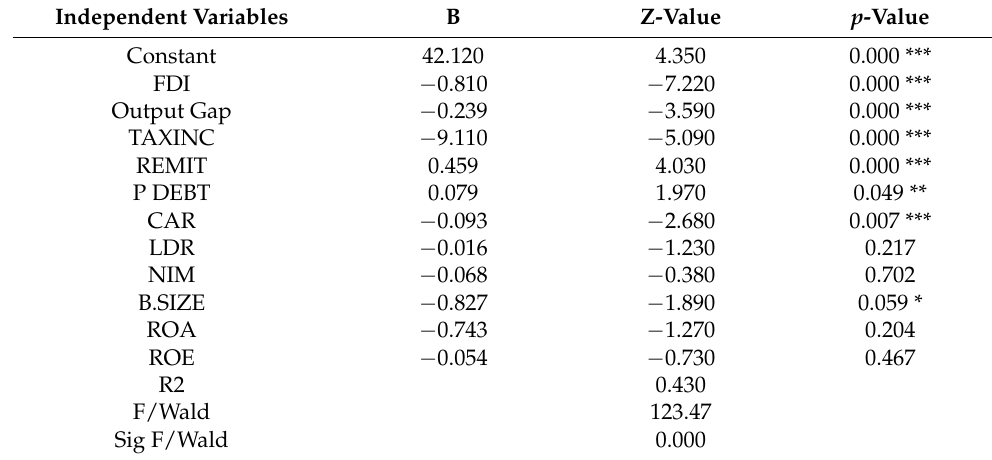
Table 8. Testing the linear regression for CR using random effect